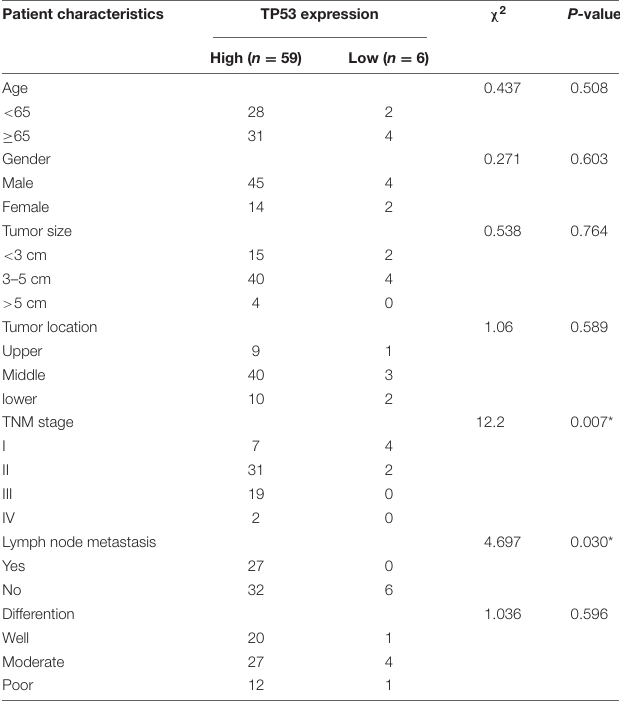
TABLE 1 | Association of clinicopathological data and expression of TP53 in ESCC